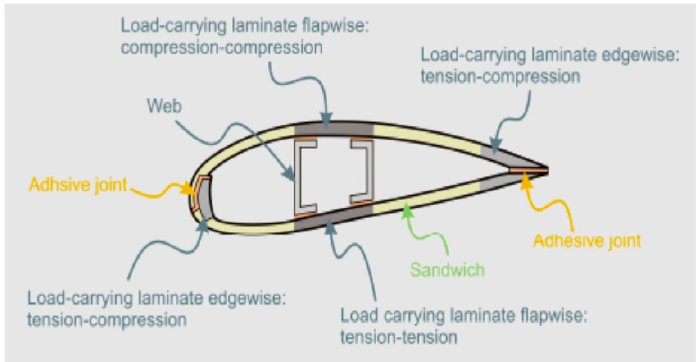
Figure 9. Schematics of a section of a wind turbine blade (Reprinted with permission from Ref.